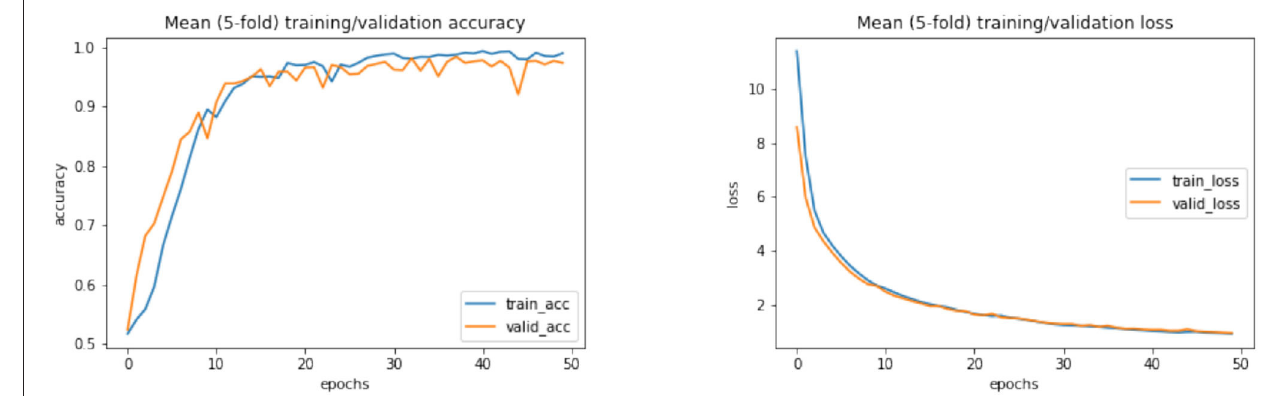
FIGURE 9 | Results for different proposed DL methods with different activation functions and z -score normalization. DL, deep learning.